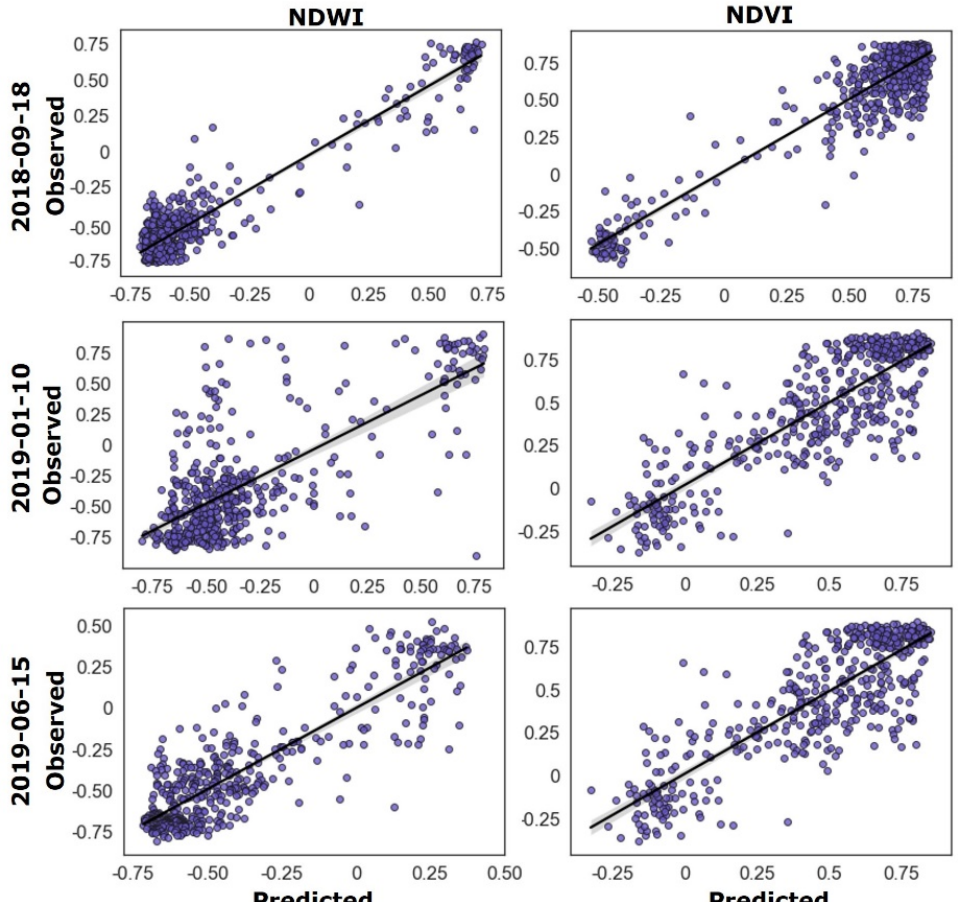
Figure 9. Scatterplots of observed NDVI and NDWI as a function of SAR-predicted NDVI and NDWI for each of the three different seasons of imagery.